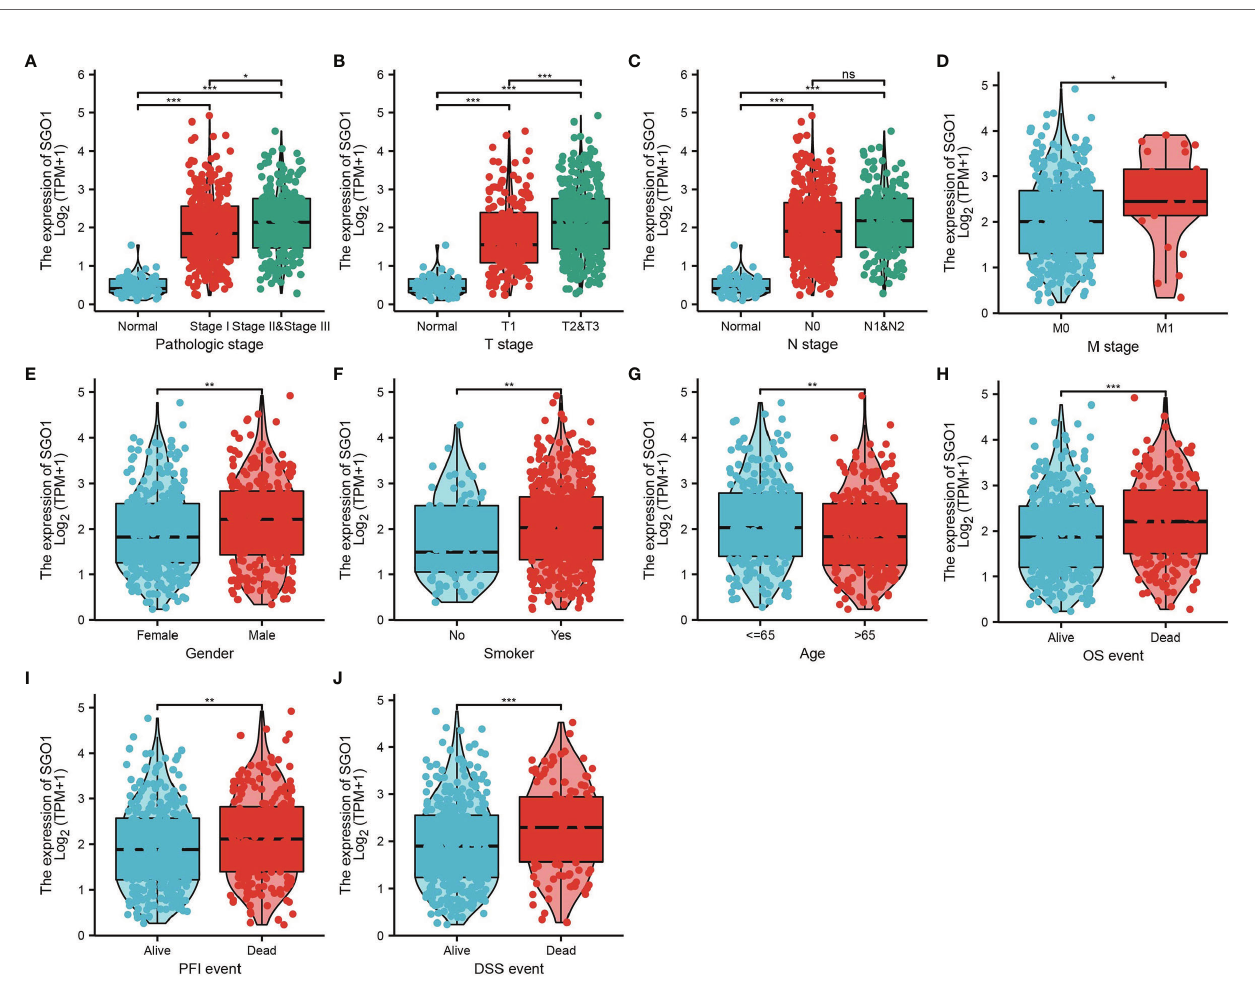
FIGURE 3 | Clinical signi fi cance of SGO1 in LUAD. (A – J) Correlation between SGO1 expression and clinical parameters, including the pathological stage, TNM stage, smoking, age, gender, OS event, DSS event, and PFS event. NS: P<0.05, *P < 0.05, **P < 0.01, and ***P < 0.001.